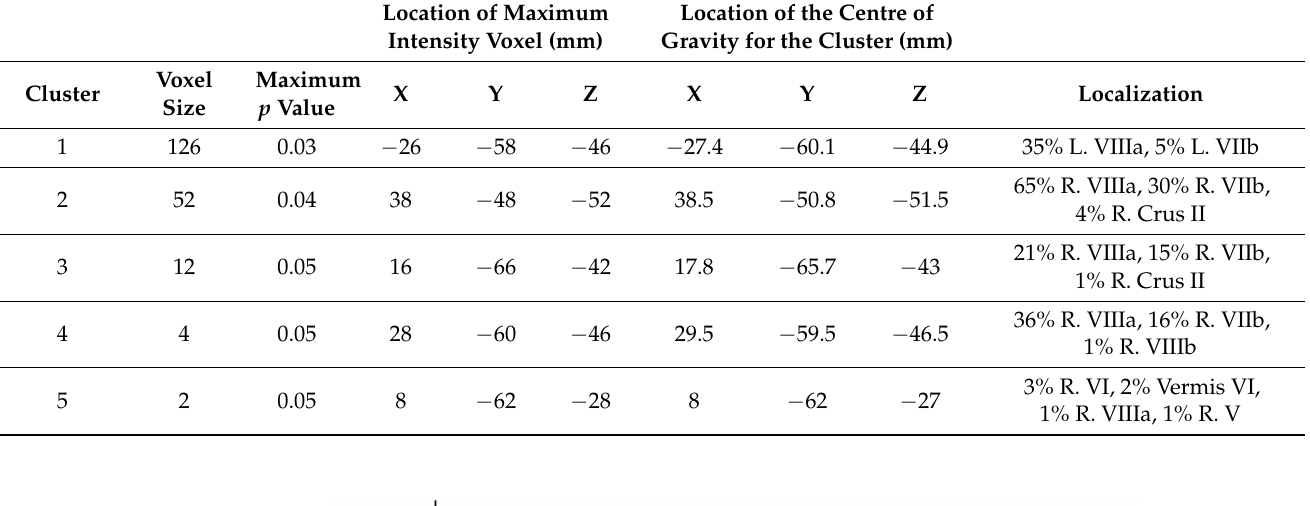
Table 1. Cluster index and size for Figure 1. Cluster index was extracted using the FSL tools Cluster and Atlasquery and are corrected for multiple comparisons.